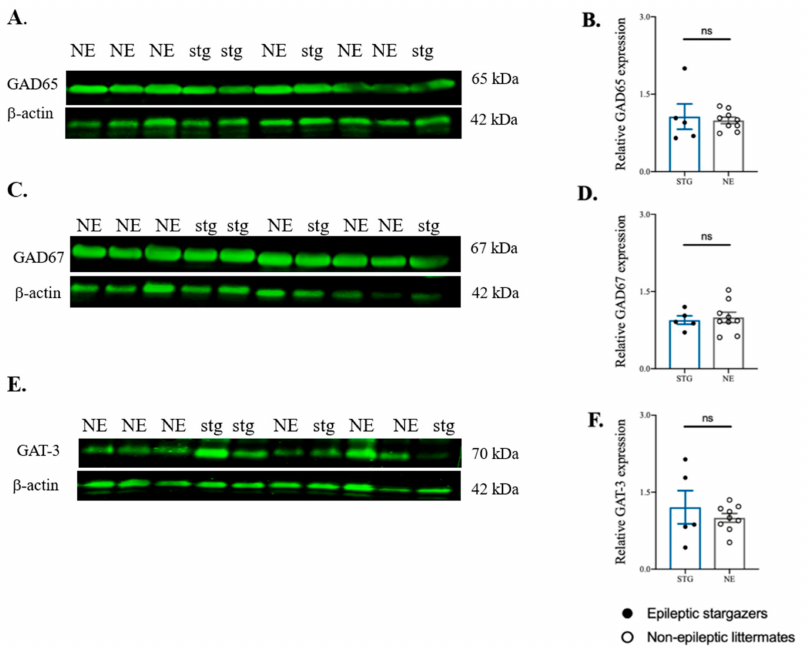
Figure 7. Western blot analysis of GAD65, GAD67, and GAT-3 in the VP thalamus of stargazers (stg) and non-epileptic littermates (NE). ( A , C , E ) Representative immunoblots showing expression of GAD65, GAD67, and GAT-3 with β -actin. ( B , D , F ) Relative expression of GAD65, GAD67, and GAT-3 in the VP thalamus presented as bar graphs. All values represent